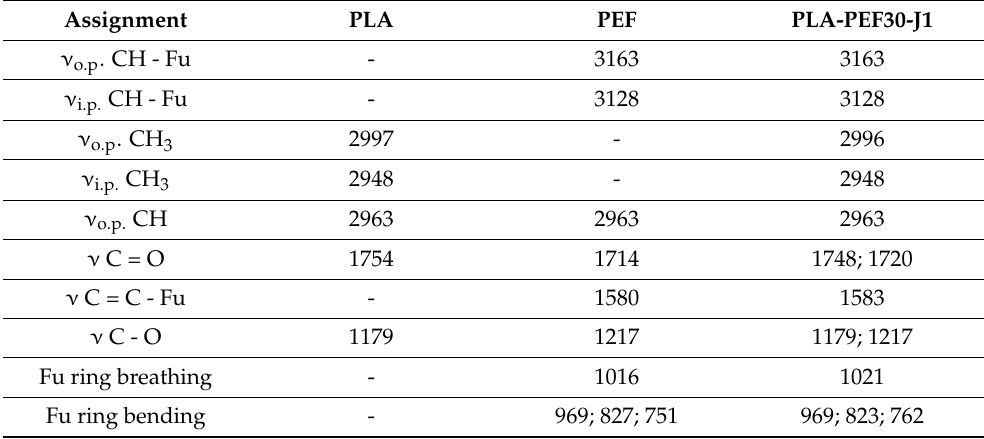
Table 2. Results of FT-IR analysis. Band position (cm − 1 ) and assignment of the main signals from the sample PLA, PEF, and PLA-PEF10.